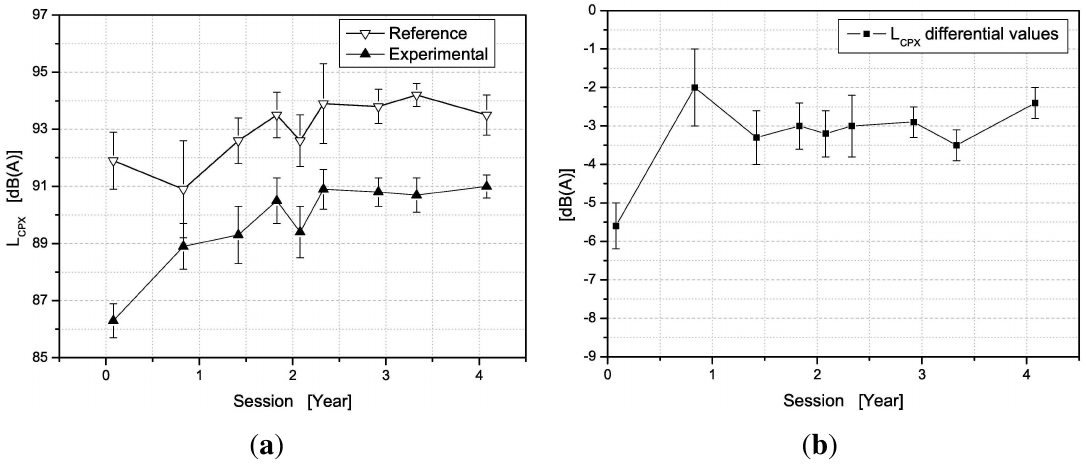
along measurement sessions CPX